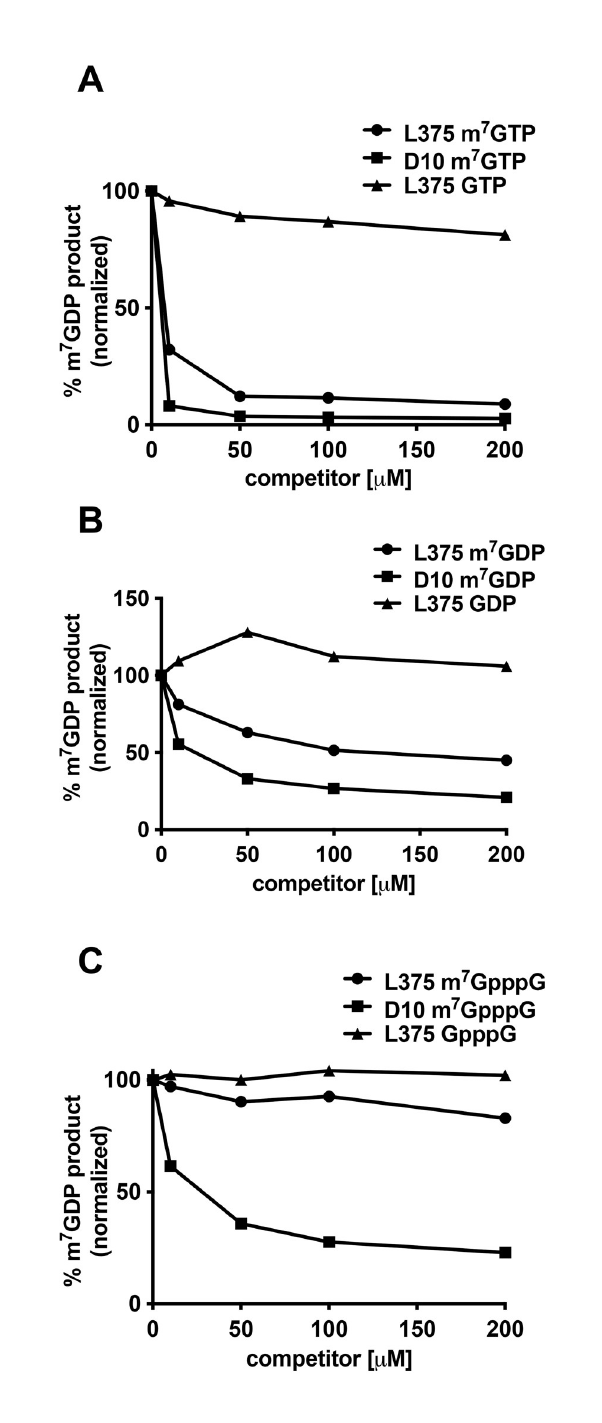
Fig 7. Recombinant L375 mRNA decapping activity is inhibited by addition of m 7 GTP or m 7 GDP. (A) 80 ng of recombinant L375 or VACV D10 and 0.02 pmol 32 P-cap-labeled actin RNA were incubated together in the presence of increasing quantities of m 7 GTP or GTP in mRNA decapping assays as described in Fig 2B. The percentage of m 7 GDP liberated was calculated through PhosphorImager analysis. (B) mRNA decapping assays were performed as in Panel A with increasing amounts of m 7 GDP or GDP. (C) mRNA decapping assays were performed as described in Panel A with increasing amounts of m 7 GpppG cap analog or GpppG.